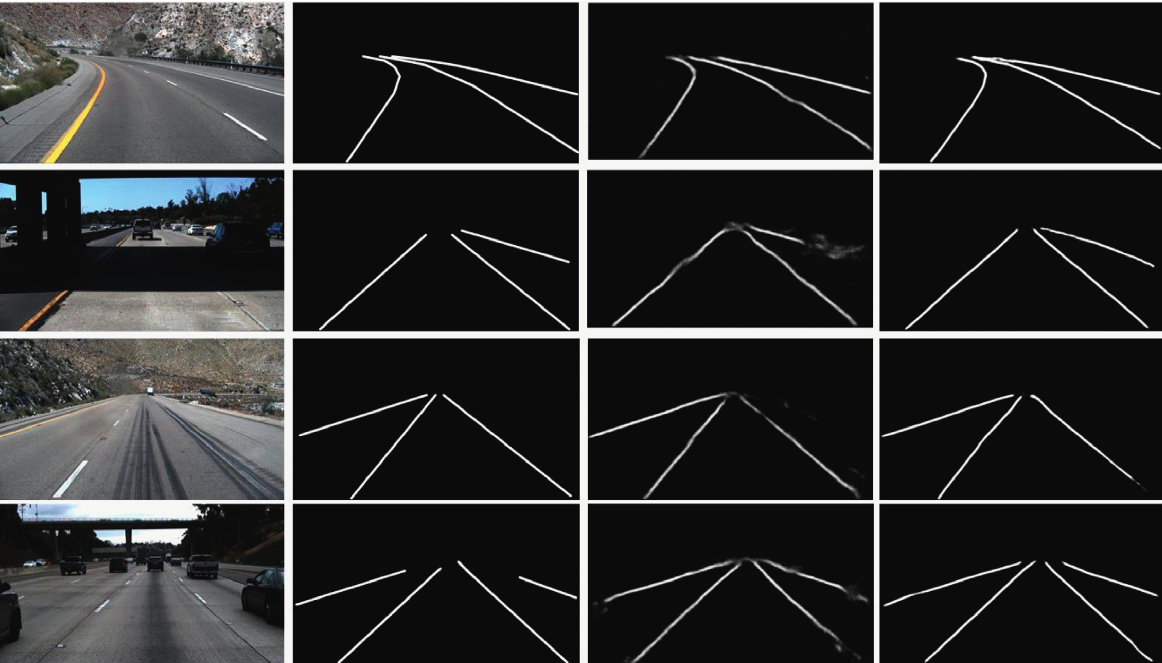
Figure 7: Lane prediction in white of proposed network with and without edge supervision. From left to right are the original pictures, labels, segmentation results without edge supervision, and segmentation results with edge supervision. The lane predicted with edge supervision is clearer and more